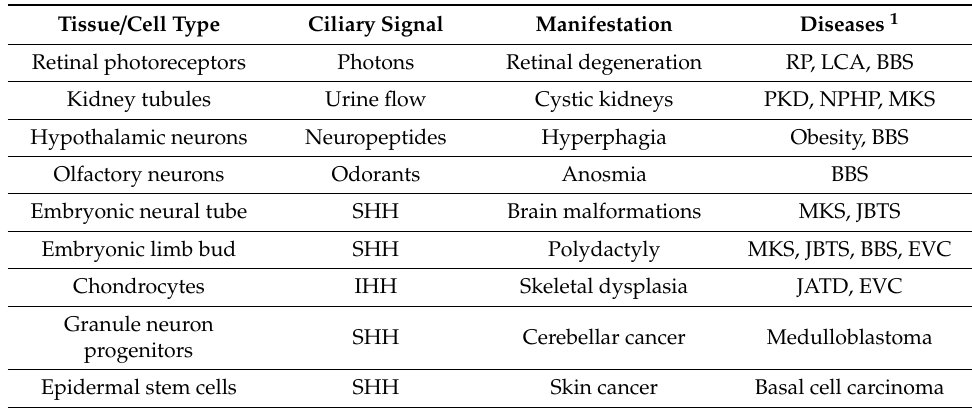
Table 1. Primary cilia and human